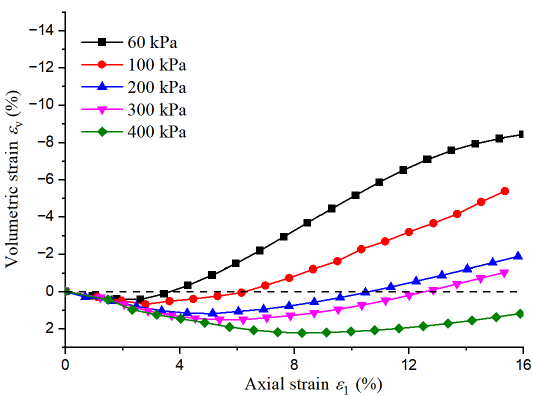
Figure 10. Volumetric strain–axial strain curves under different confining pressures.